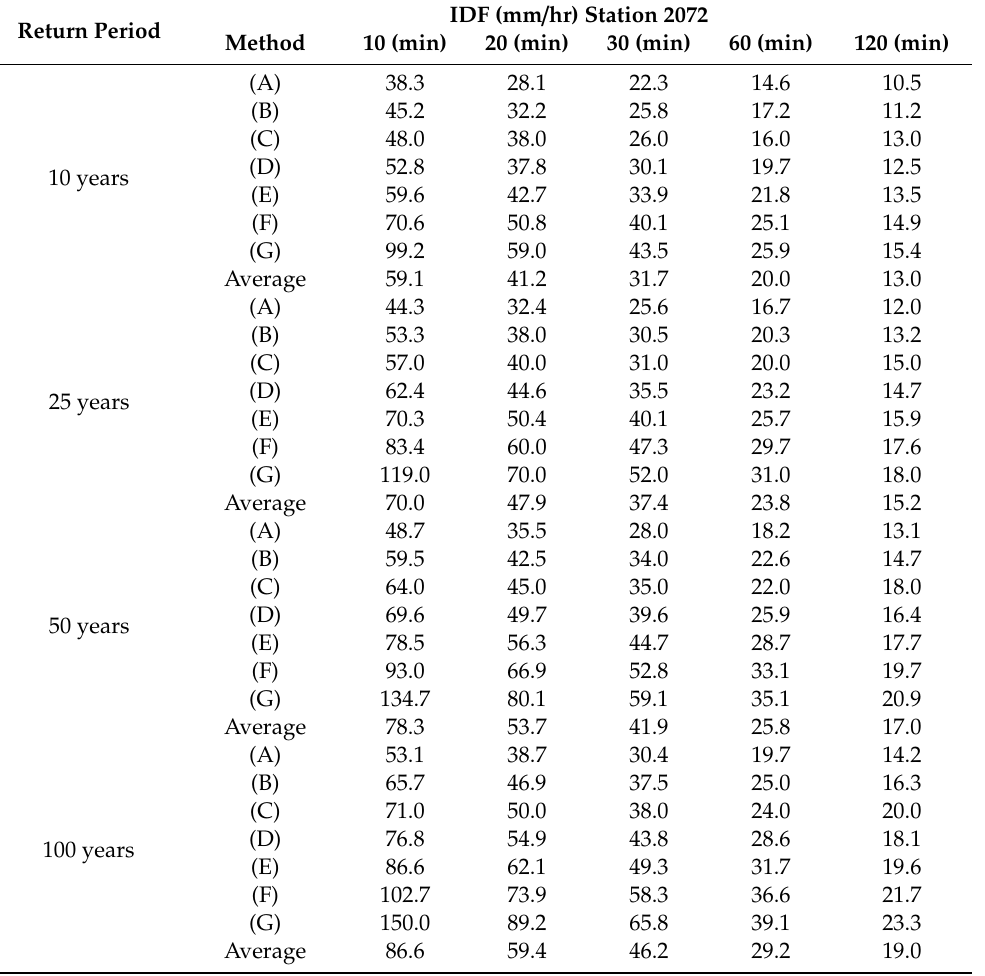
Table 6. First comparison of IDF relationship, estimated through di ff erent methods for station 2072 for di ff erent return